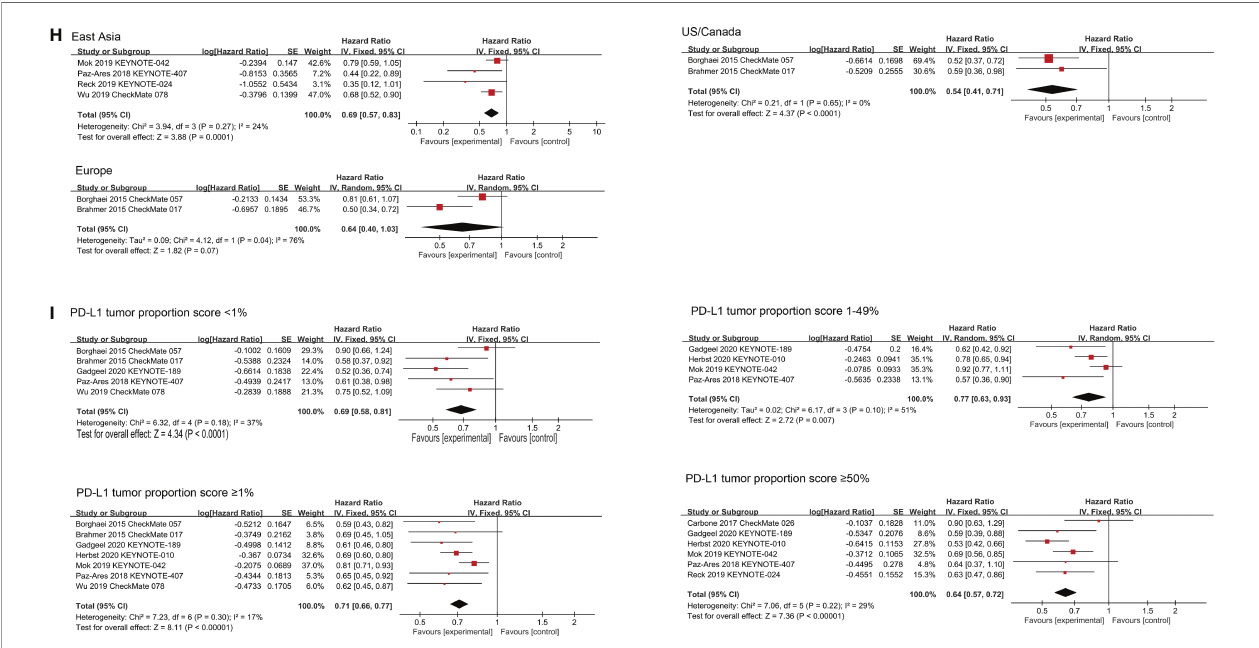
FIGURE 3 | Forest plots of HRs comparing OS between PD-1 inhibitors based therapy and non-PD-1 inhibitor based therapy with respect to (A) age group, (B) gender, (C) histomorphological subtypes, (D) PS score, (E) smoking status, (F) metastases status/site, (G) EGFR mutation status, (H) region and (I) PD-L1 tumor proportion